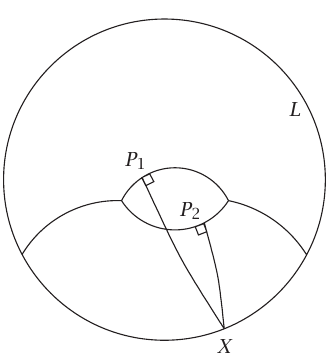
Figure 7.1 . A bubble which can be separated by cutting at points from which orthogonal lines intersect the axis of revolution at the same